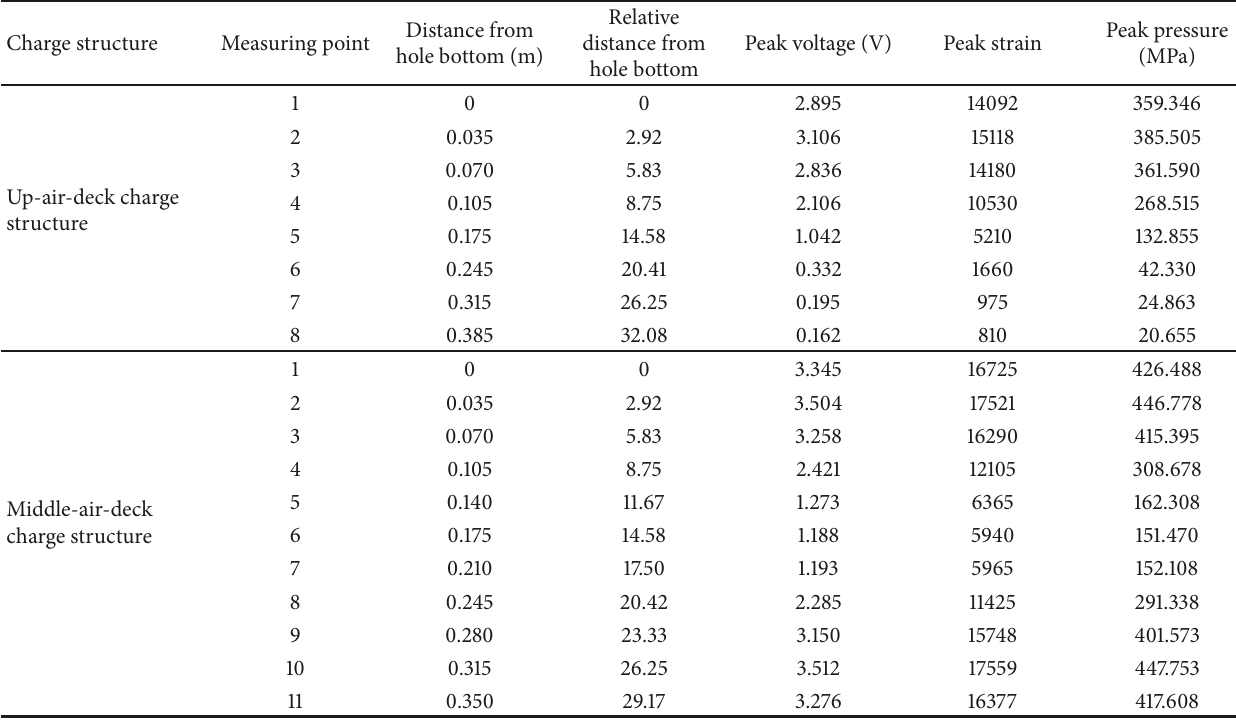
Table 3: Experimental results of upper and middle air-decked charging structure.